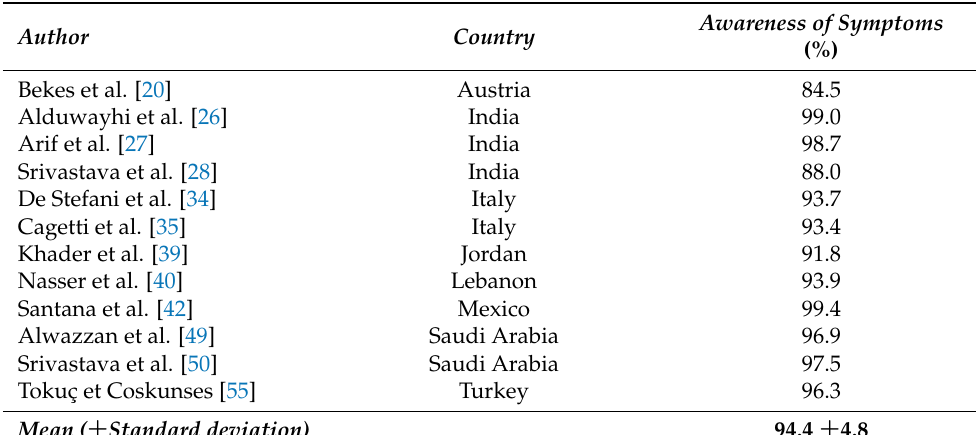
Table 3. Awareness percentage of symptoms in the included